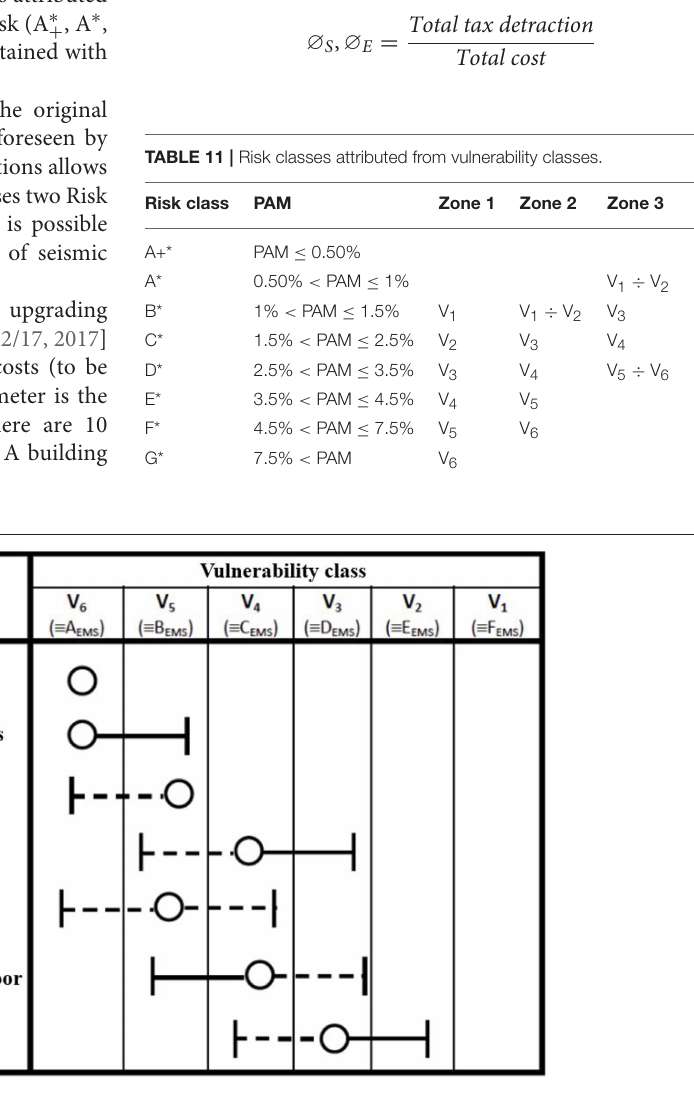
FIGURE 12 | Simplified approach for the masonry Vulnerability Class attribution.